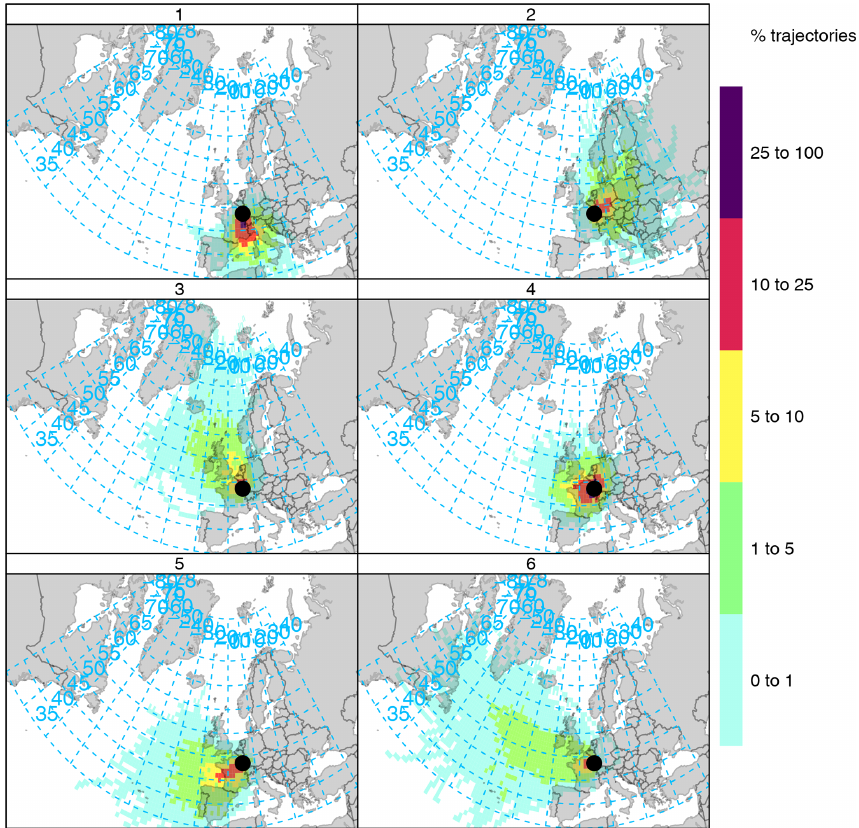
Figure 2. The 96h back-trajectory frequencies reaching the OPE station top level for each of the six clusters identified using the HYSPLIT tools and the NCEP reanalysis for the period